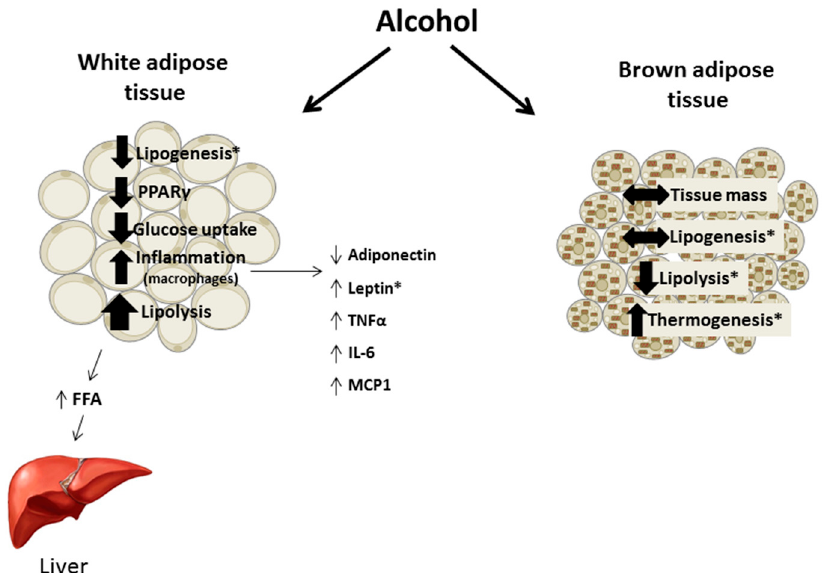
Figure 3. Summary of the effects of chronic alcohol on white and brown adipose tissue function. In white adipose tissue, alcohol leads to overall loss of tissue mass due to enhanced lipolysis and either unchanged or decreased lipogenesis. FFAs released following lipolysis are commonly deposited in the liver contributing to alcoholic steatosis. Glucose uptake is also perturbed by alcohol. A heightened inflammatory state develops from chronic alcohol consumption leading to increased macrophage infiltration and expression of the indicated adipokines/cytokines. Within brown adipose tissue conclusive data are limited but suggest a lack of change in tissue mass and lipogenesis as well as a decrease in lipolysis and potential increase in thermogenesis. * Indicates where findings have been variable and inconclusive but suggest the indicated effect. Abbreviations: peroxisome proliferator activated receptor γ (PPAR γ ), tumor necrosis factor α (TNF α ), interleukin ‐ 6 (IL ‐ 6), and monocyte chemoattractant protein ‐ 1 (MCP1).